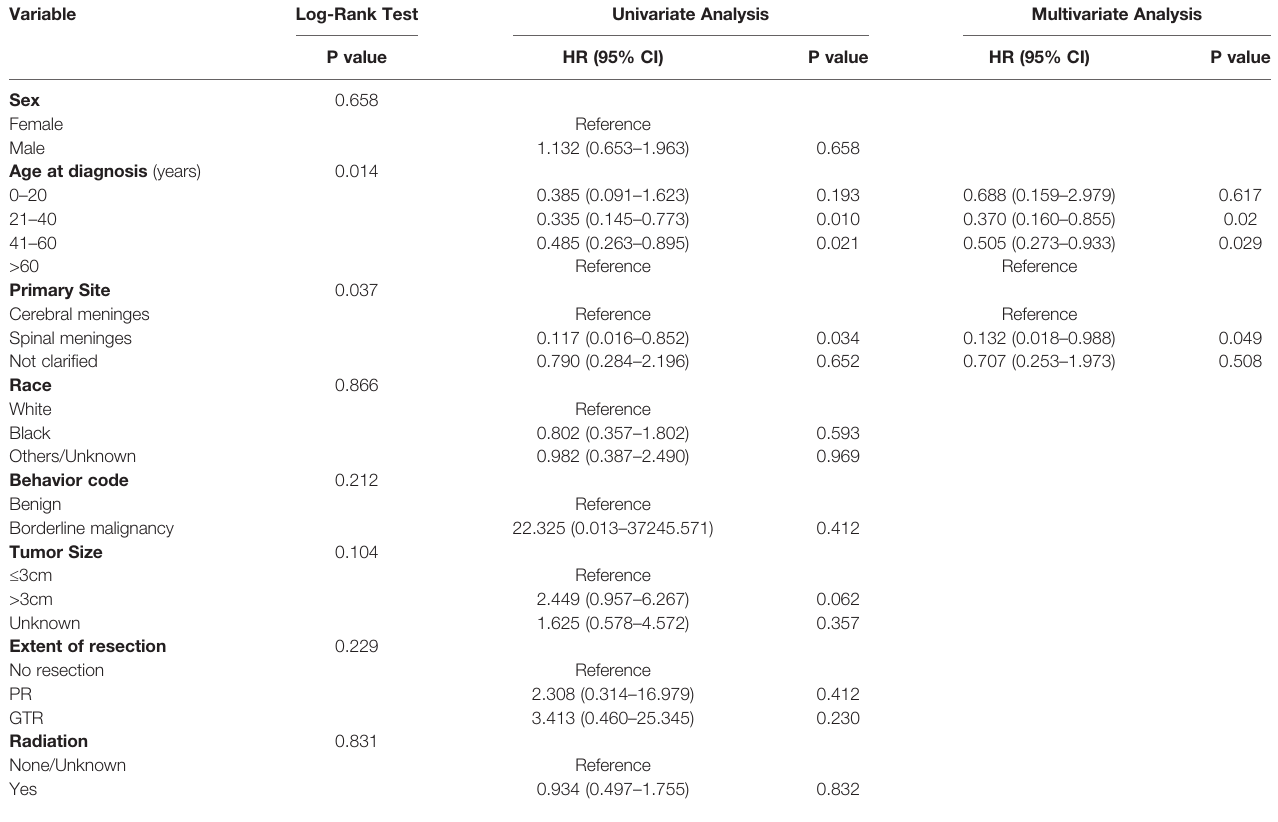
TABLE 2 | The results of the log-rank test, and univariate and multivariate Cox regression analysis.